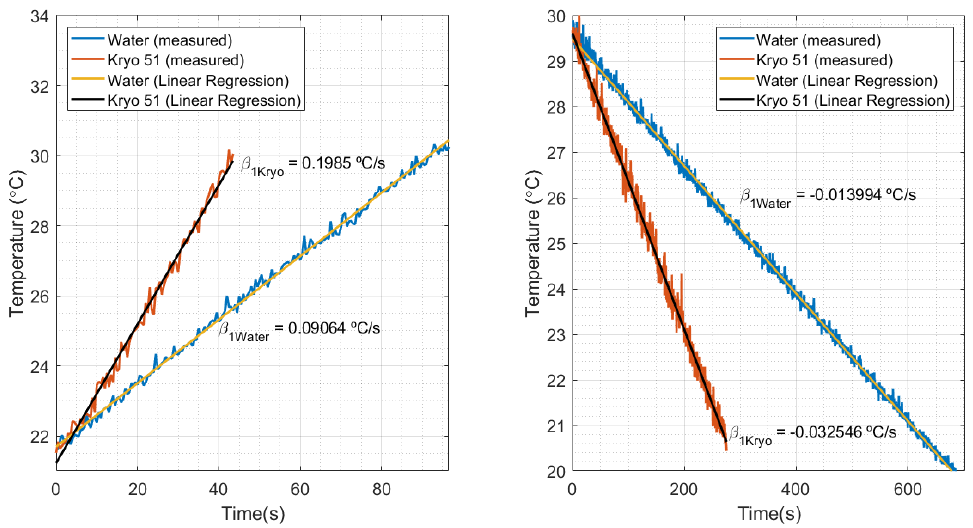
Figure 9. Temperature in relation to time and its respective slopes, measured in the thermostat bath experiment for water and Kryo 51